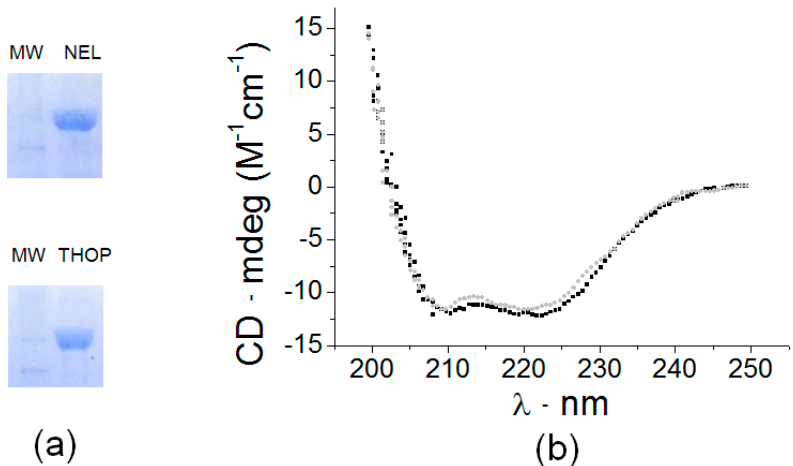
Figure 1. Purification of recombinant oligopeptidases THOP (EC 3.4.24.15) and NEL (EC 3.4.24.16). ( a ) Twelve percent SDS-Page of purified recombinant THOP and NEL followed by Coomassie Blue staining, indicating the purification homogeneity. ( b ) Circular dichroism profile of rTHOP and rNEL, demonstrating a proper fold after purification. All samples were prepared, and the spectra obtained, as described in Materials and Methods.